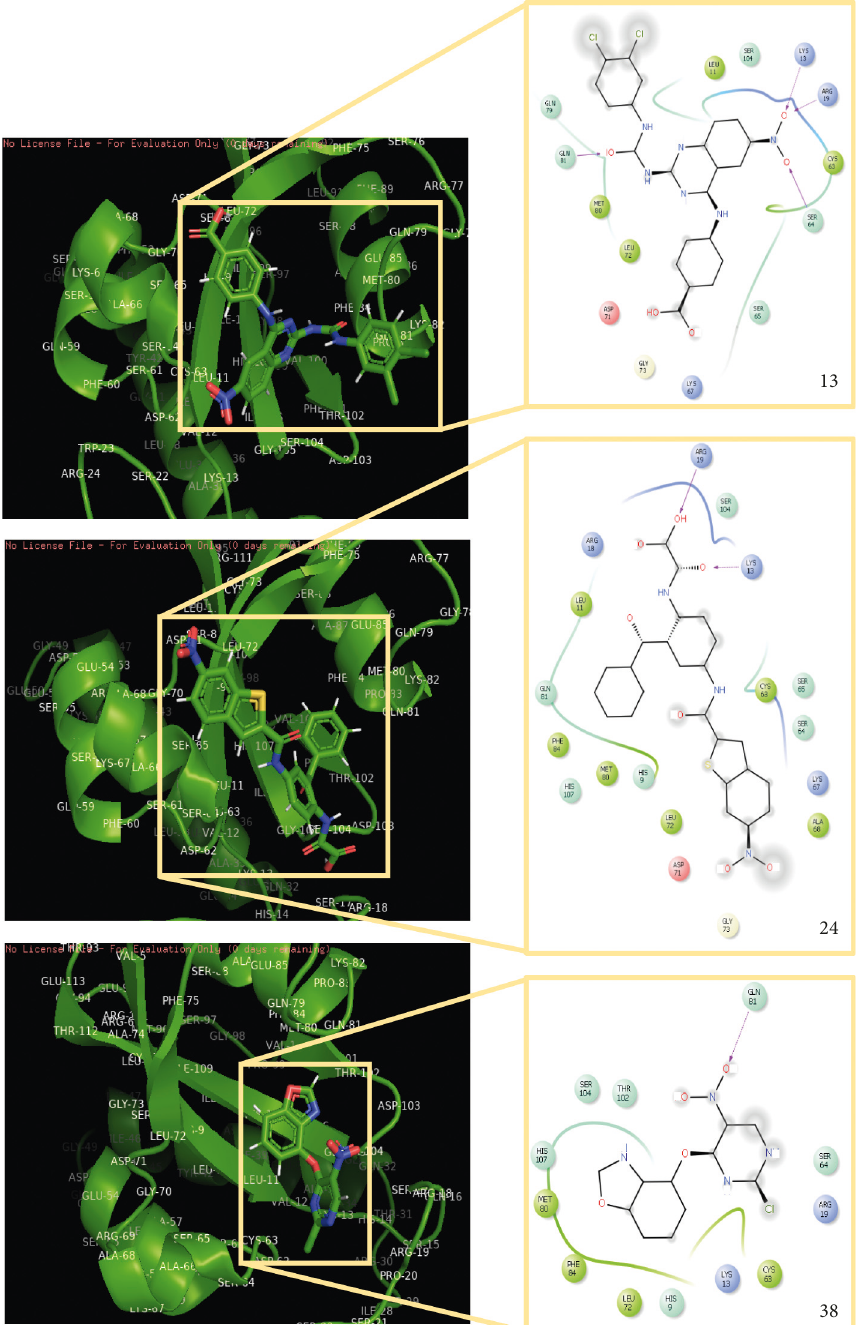
Figure 6: Docking illustration for compound 13, 24, and 38, which are most active compounds in the